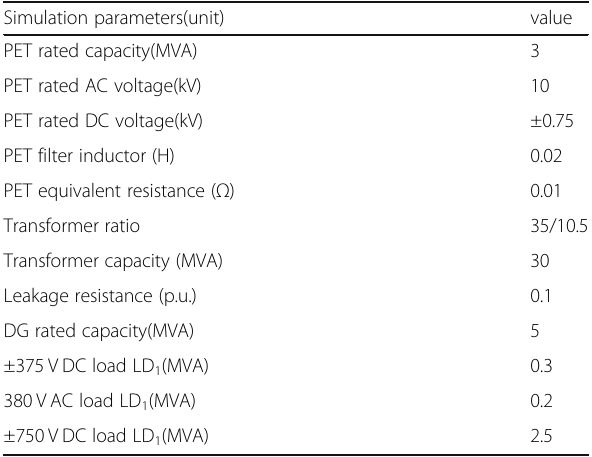
Table 1 Parameters of simulation system